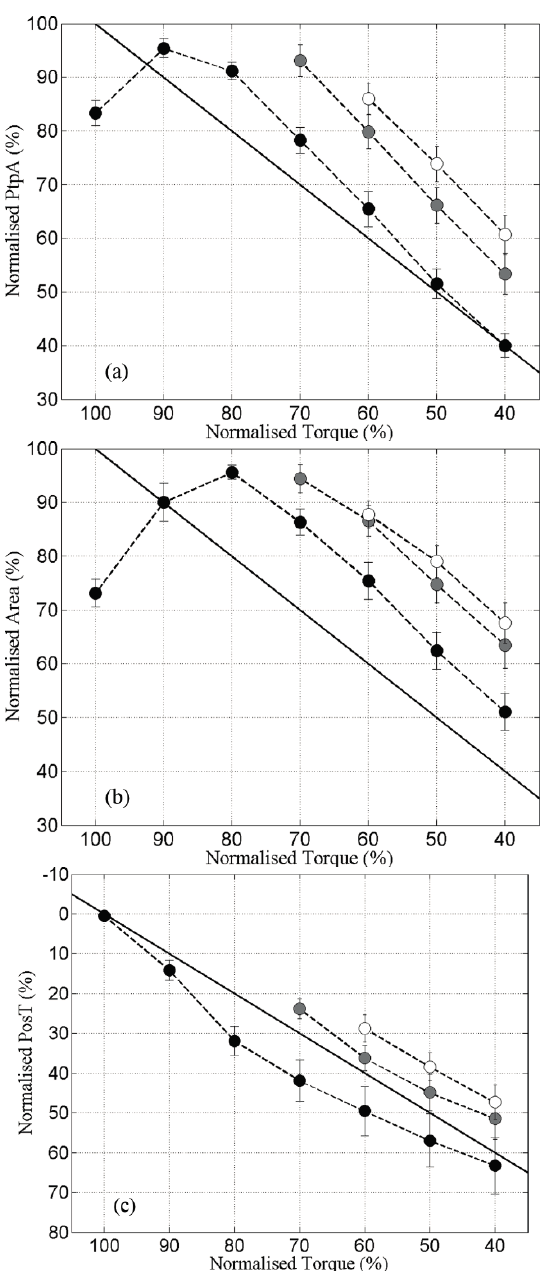
Figure 3. ( a ) PtpA × Torque; ( b ) Area × Torque and ( c ) PosT × Torque curves obtained during c1( ● ), c2 ( ● ) and c3 ( ○ ). Note that in ( c ) the y axis was intentionally inverted as PosT fatigued values were maximum, thus set as 100%. X axis represents normalised torque (%) reduces with time. The solid diagonal lines represent lines of identity. Data are mean ± standard